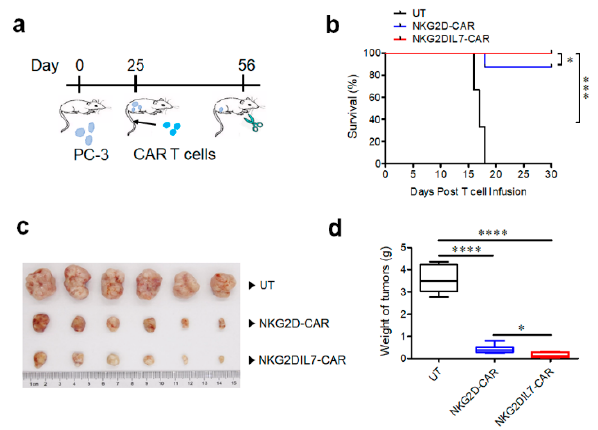
Figure 5. Engineering expression of IL-7 enhances the antitumor activity of NKG2D-CAR T cells in the xenograft prostate tumor model. ( a ) A schematic of in vivo experiment. ( b ) Kaplan-Meier survival analysis of PC-3 challenged mice after treatment with CAR-T cells. ( c , d ) The photograph of residual tumors ( c ) and the tumor weight ( d ) of the mice treated with NKG2D-CAR and NKG2DIL7-CAR T cells at the endpoint of the experiments. * p < 0.05, *** p < 0.001, **** p < 0.0001, n = 6.